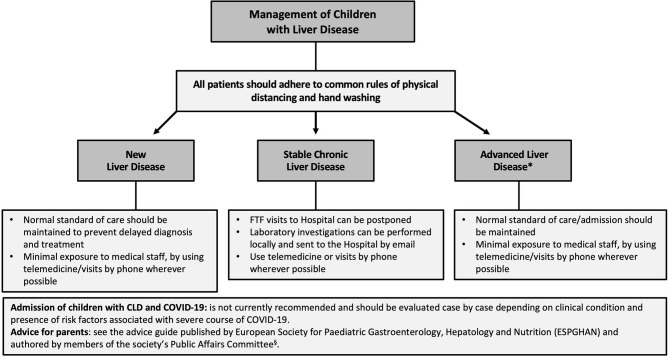
Flow chart for the management of children with chronic liver disease (CLD) during the COVID-19 outbreak. Individual management of these patients strongly depends on the local COVID-19 burden and officially implemented rules and regulations. *It includes children with an impaired liver function (coagulopathy and/or low serum albumin) or complications of portal hypertension (ascites and/or gastro-esophageal varices). FTF, face-to-face.